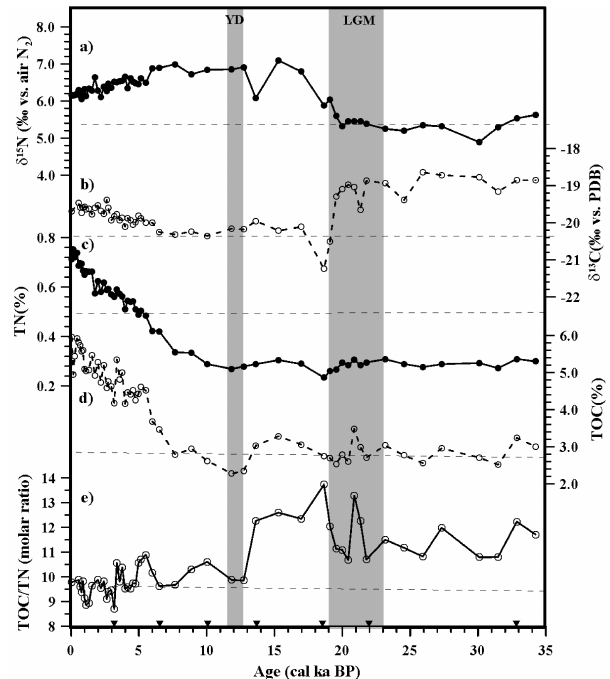
Figure 3. Temporal variations of (a) stable isotopic compositions of bulk nitrogen ( δ 15 N); (b) stable isotopic compositions of total organic carbon (TOC) ( δ 13 C); (c) contents of total nitrogen; (d) to- tal organic carbon; (e) TOC/TN ratio. Horizontal dashed lines are references for low value